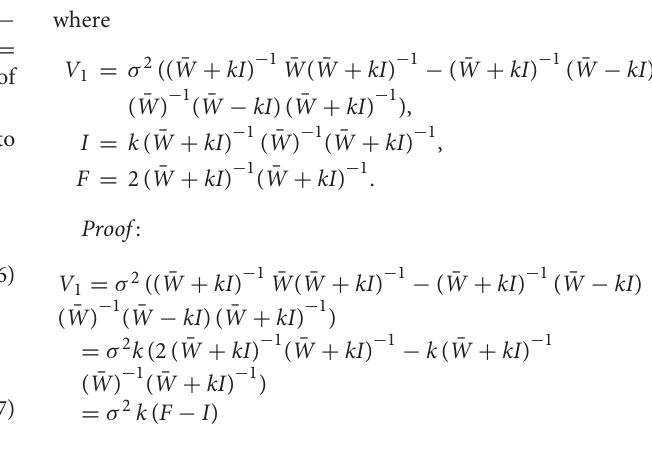
TABLE 5 | Simulation results in case of p